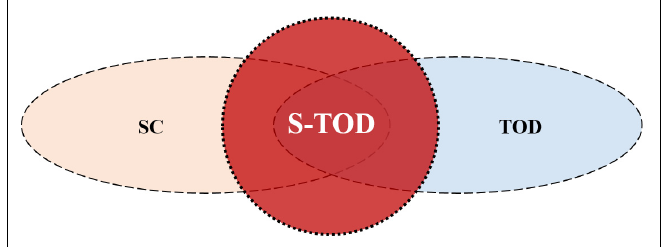
Figure 3. The logical relationship between SC, TOD, and S-TOD.